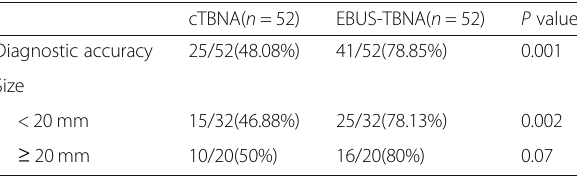
Table 3 Diagnostic Rate of cTBNA and EBUS-TBNA in the Paired Design